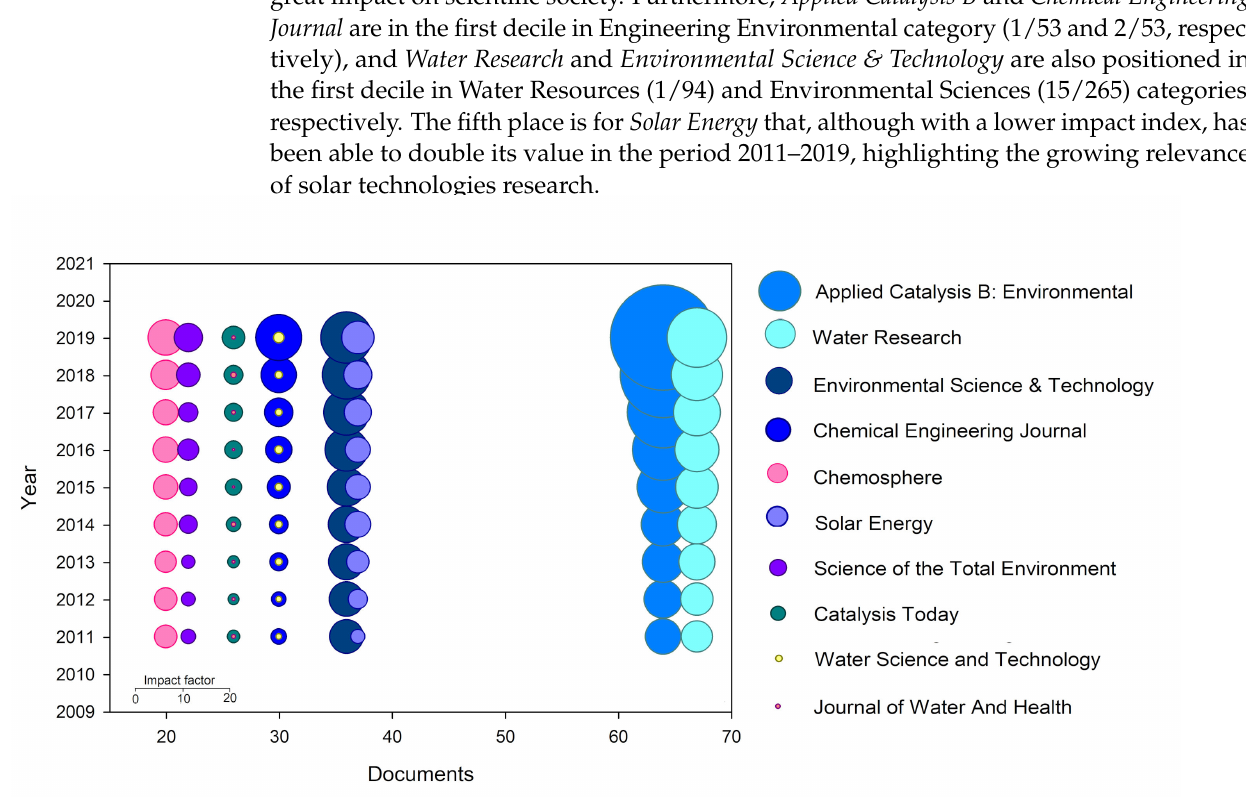
Figure 3. Journals with the highest number of articles on solar-driven disinfection and evolution of the impact index over the last 10 years for the journals with the highest number of documents. The size of the circles represents the impact factor according to the scale